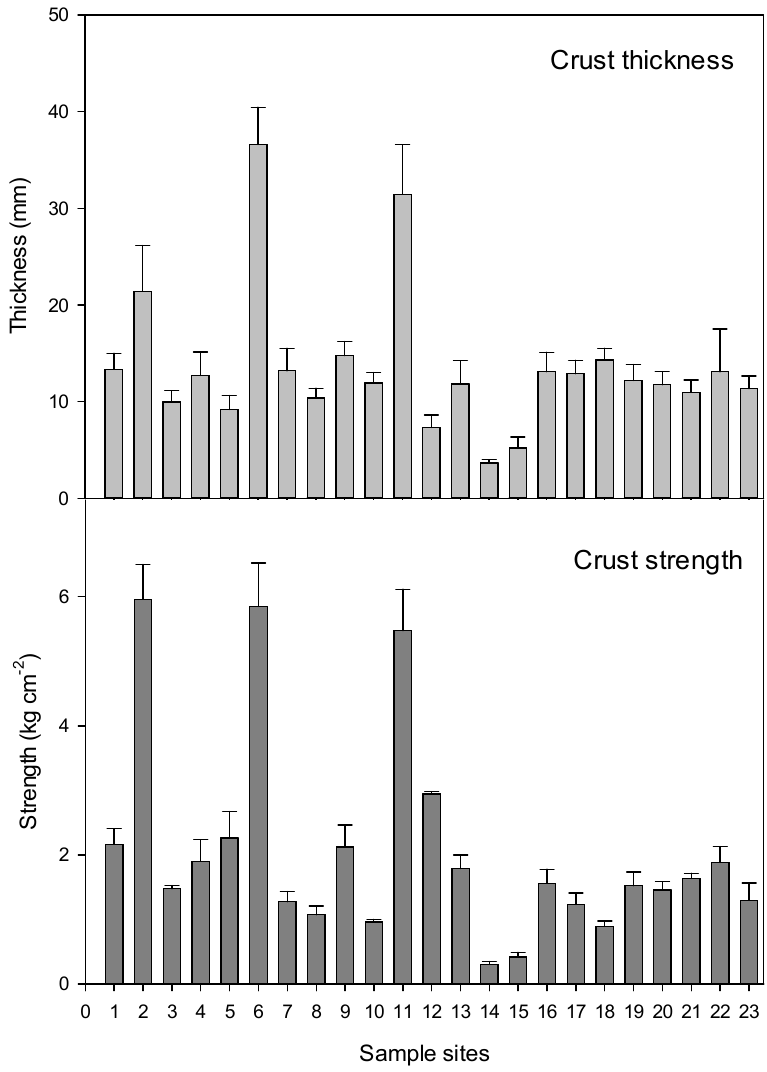
Figure 5. Thickness and strength of salt crusts in the Tarim River Basin.